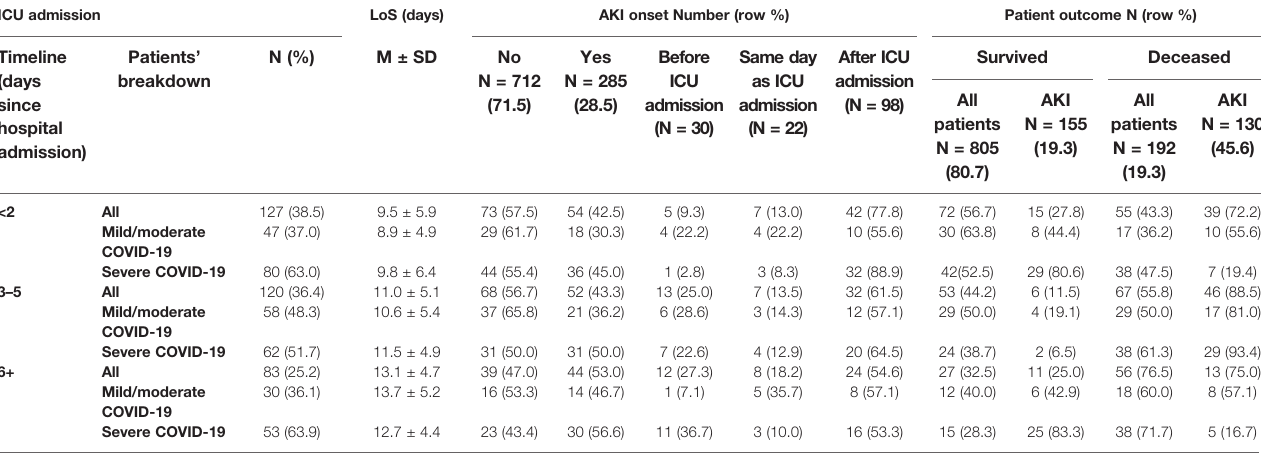
TABLE 2 | Distribution of timeline of intensive care unit (ICU) admission, by severity of COVID-19, length of hospital stay (LoS, in days), acute kidney injury (AKI) onset (yes vs. no), and patient outcome (death vs. survival). Number (N), percentages (%), mean (M) ± standard deviation